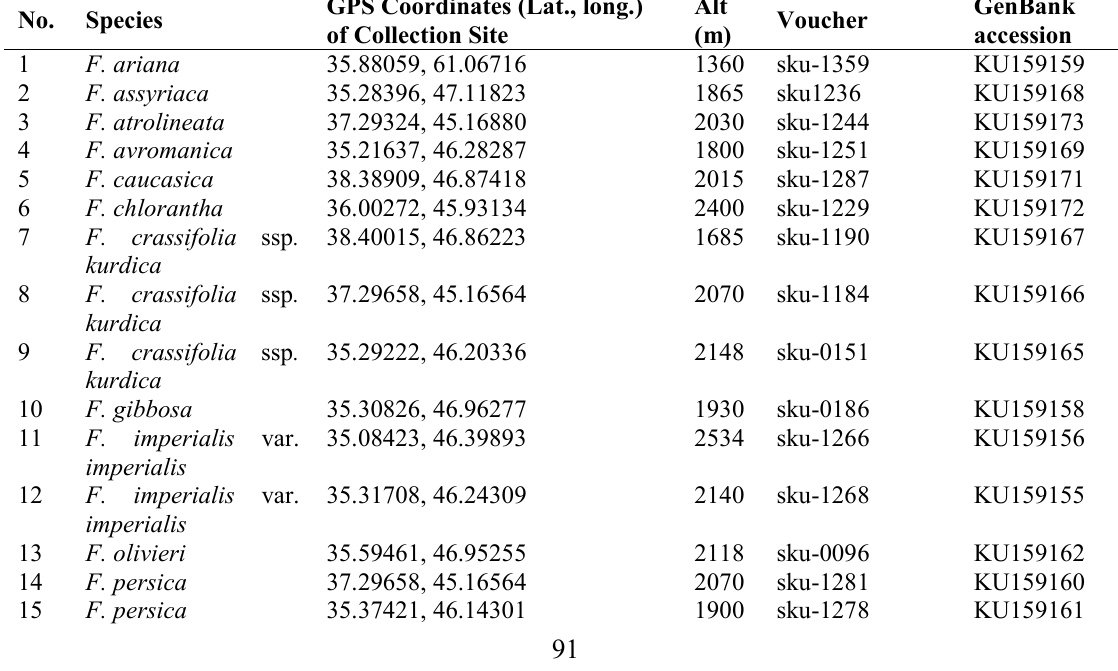
Table 1. Plant material. Specimens are preserved at the Herbarium of Shahrekord University (SKU). All the specimens are sequenced in this study (except for L. ledebourii).